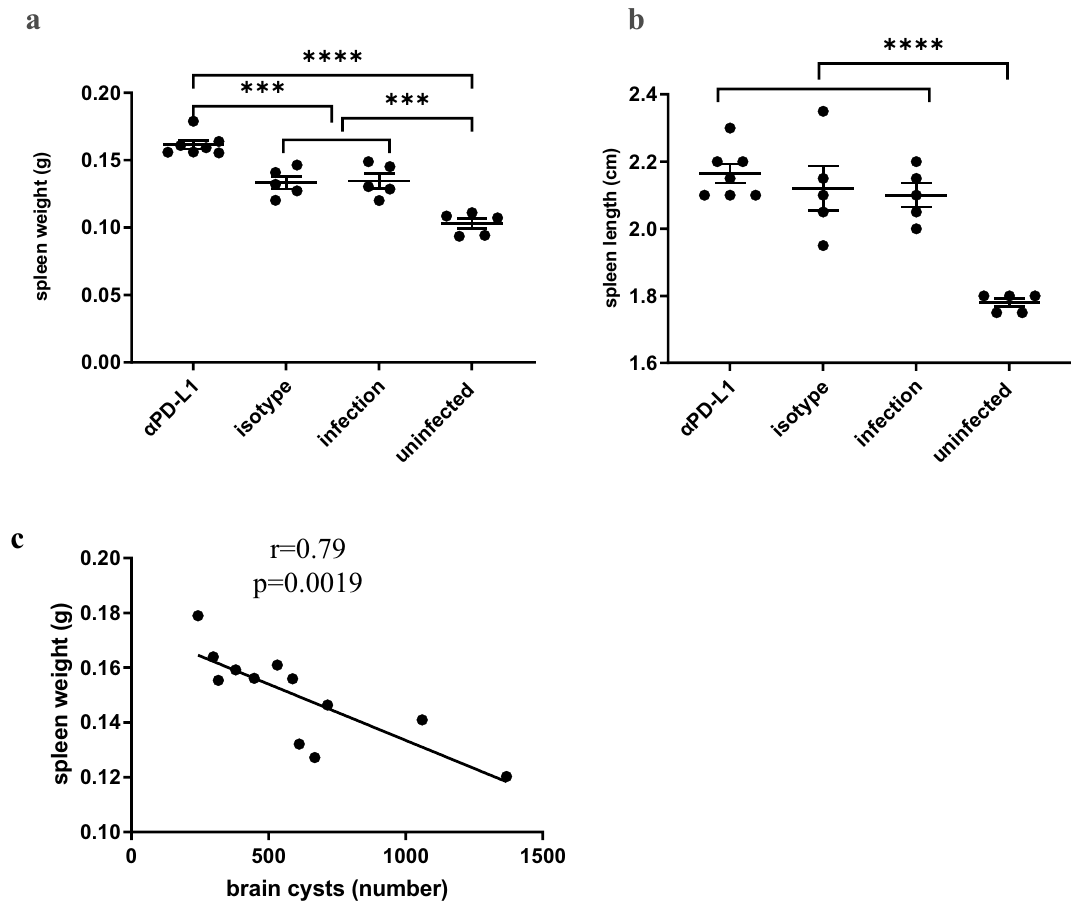
Figure 2. Effects of anti-PD-L1 treatment on mouse spleens. Differences in spleen weights ( a ) and lengths ( b ) were shown among anti-PD-L1-treated, isotype-treated, infected, and uninfected mice. ( c ) A negative correlation between the number of brain tissue cysts and spleen weight in Toxoplasma -infected mice treated with either PD-L1 or isotype control (n = 12). Statistically significant differences were determined by one-way ANOVA followed by Bonferroni’s correction for multiple comparisons ( a & b ) or Pearson’s correlation analysis ( c ). Data are shown as mean ± SEM, with individual data points. ***, P < 0.001; ****, P <